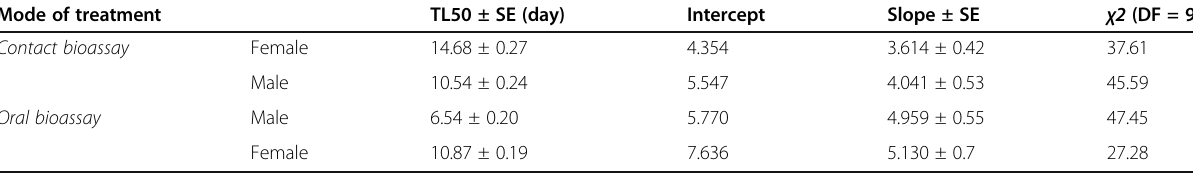
Table 1 LT 50 of adult males and females of Ceratitis capitata treated as oral and contact bioassay with Beauveria bassiana BAUM M6-4 Mode of treatment Contact